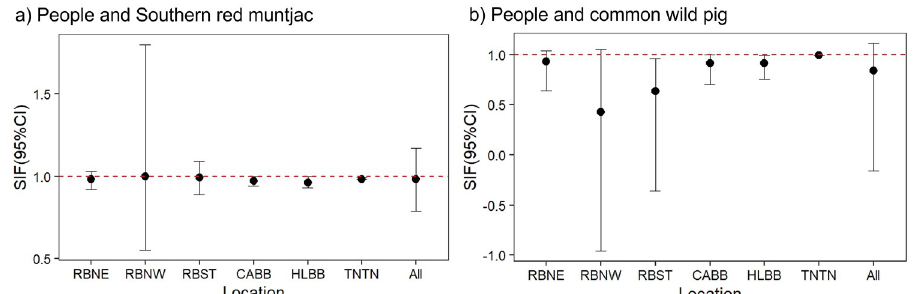
Fig 6. Spatial overlap between people (dominant, species A) and potential prey (subordinate, species B) based on model-averaged Δ AIC c � 2 for 147 camera-trap stations across all study sites. A strong SIF is indicated by the 95% CI not overlapping with “1”; RBNE, Northeastern Bukit Rimbang Bukit Baling; RBNW, Northwestern Bukit Rimbang Bukit Baling; RBST, Southern Bukit Rimbang Bukit Baling; CABB, Bukit Bungkuk; HLBB, Bukit Betabuh; TNTN, Tesso Nilo; All, “All study sites”.